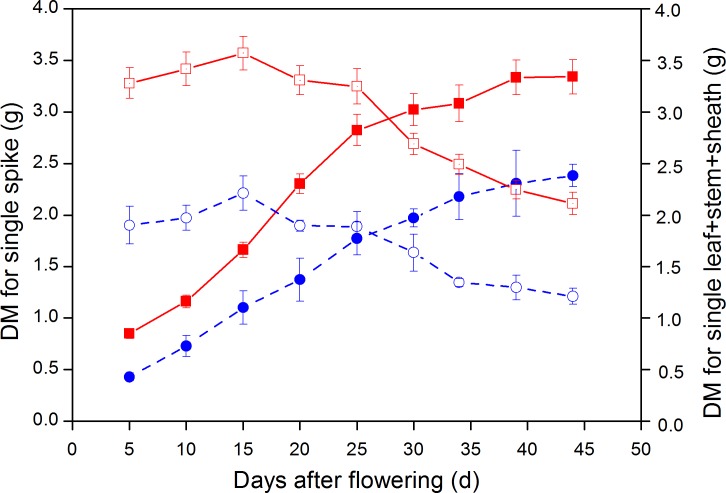
Dynamic changes in dry weight (DW) of single spike and leaf + stem + sheath in large-spike lines and CK (Xi’nong 979).■ and • indicate DW for single spikes in large-spike lines and CK, respectively; □ and \documentclass[12pt]{minimal}
\usepackage{amsmath}
\usepackage{wasysym}
\usepackage{amsfonts}
\usepackage{amssymb}
\usepackage{amsbsy}
\usepackage{upgreek}
\usepackage{mathrsfs}
\setlength{\oddsidemargin}{-69pt}
\begin{document}
}{}$\bigcirc$\end{document}○ indicate DW for leaf + stem + sheath in large-spike lines and CK, respectively.